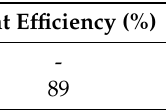
Table 3. Tensile mechanical